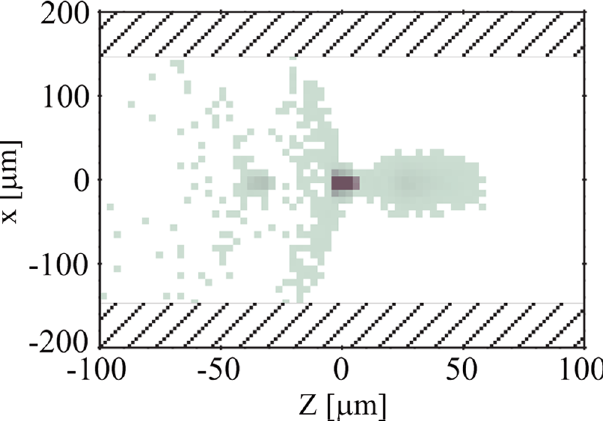
FIG. 10. (Color) Density plot of the radial profile for the electron beam just after entering the plasma with a plasma wave gen- erated by a laser of a 0 ¼ 1 : 02 and a timing variation of (cid:8)t ¼ (cid:3) 300 fs .